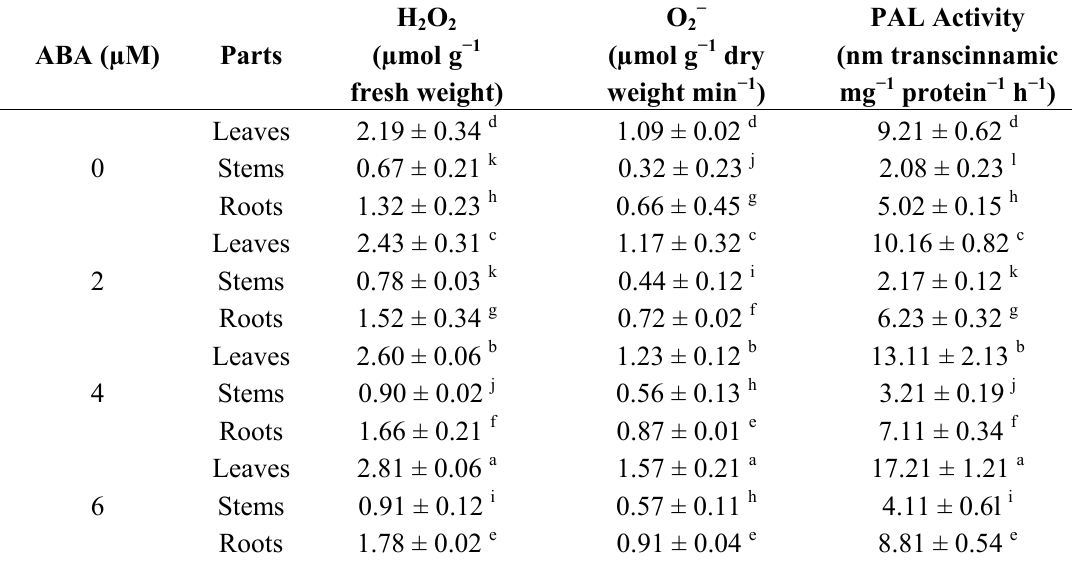
Table 3. Impact of abscisic acid levels on H Orthosiphon